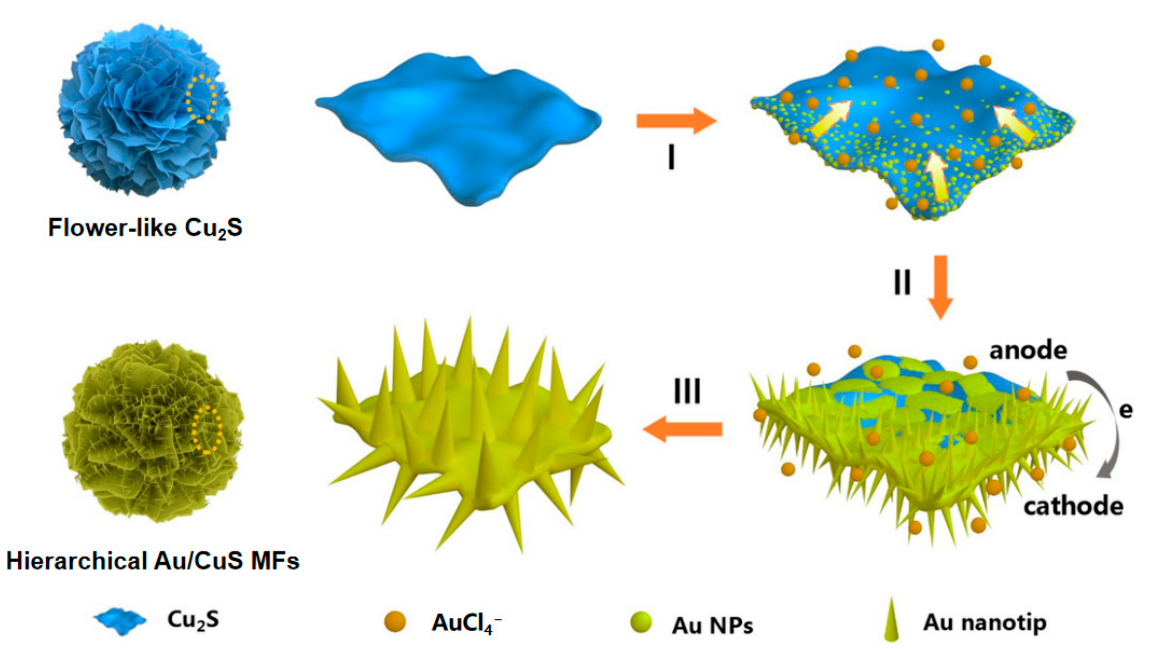
Figure 7. Schematic illustration of the formation mechanism for high-density-nanotips-composed 3D hierarchical Au/CuS MFs.